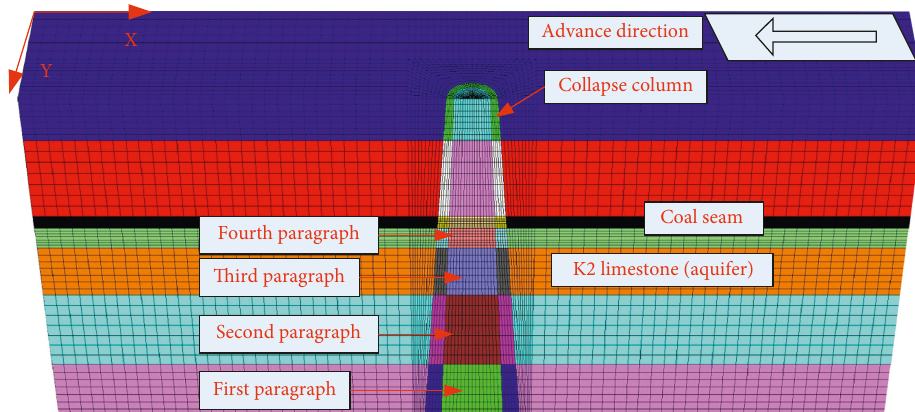
Figure 2: Model and collapse column location in FLAC3D.